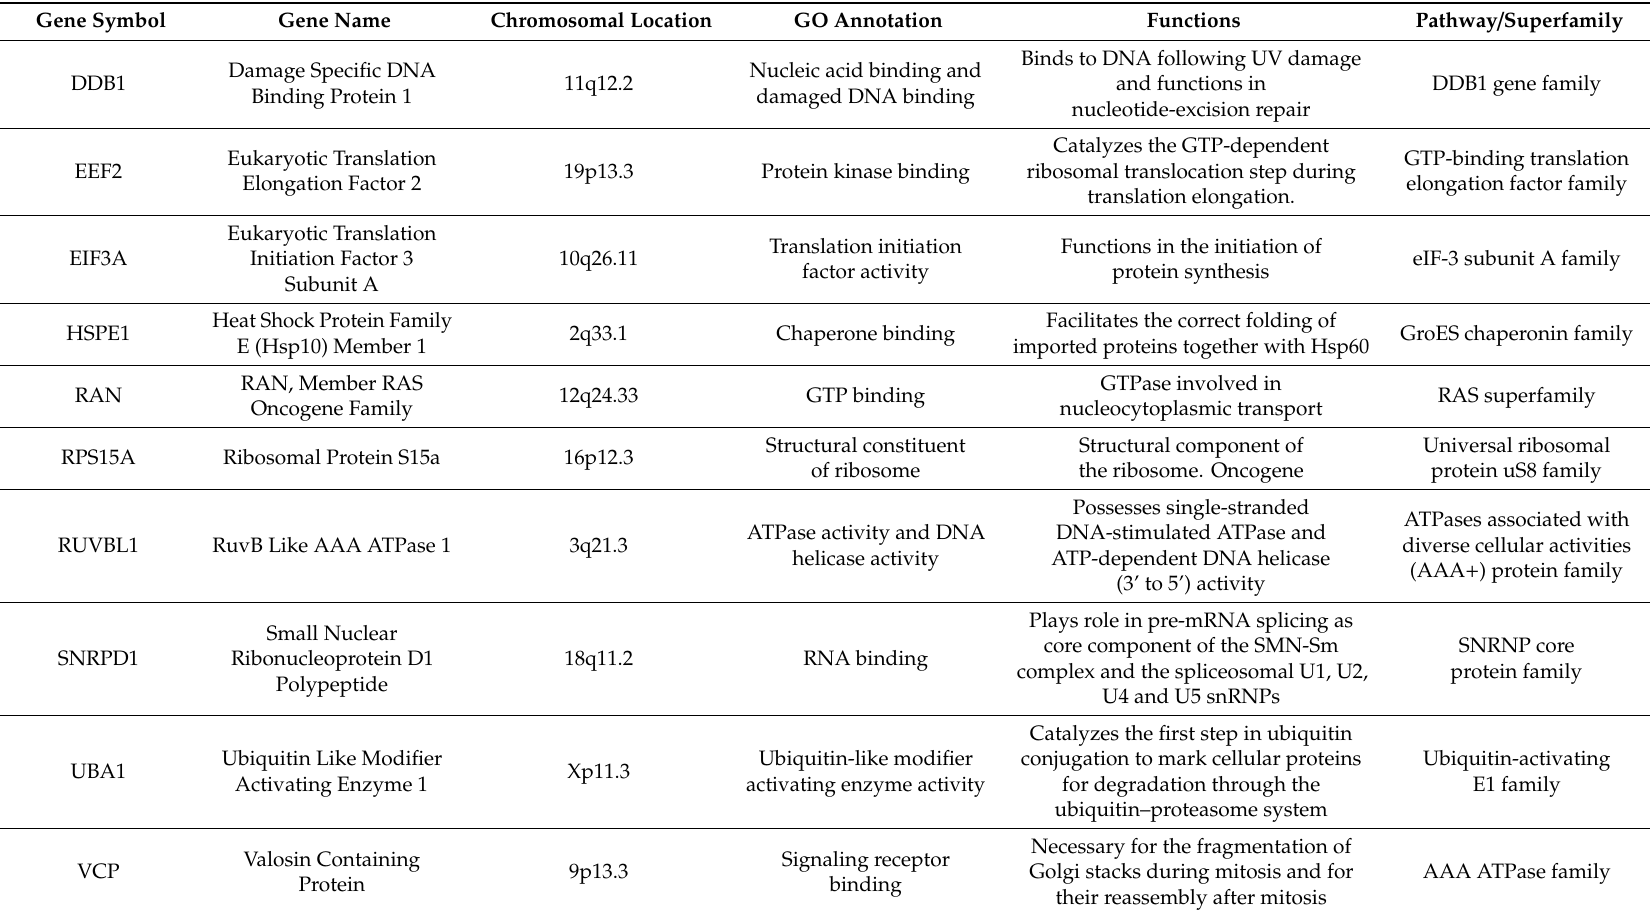
Table 3. Genomic and functional details on the common essential genes in MPM cell